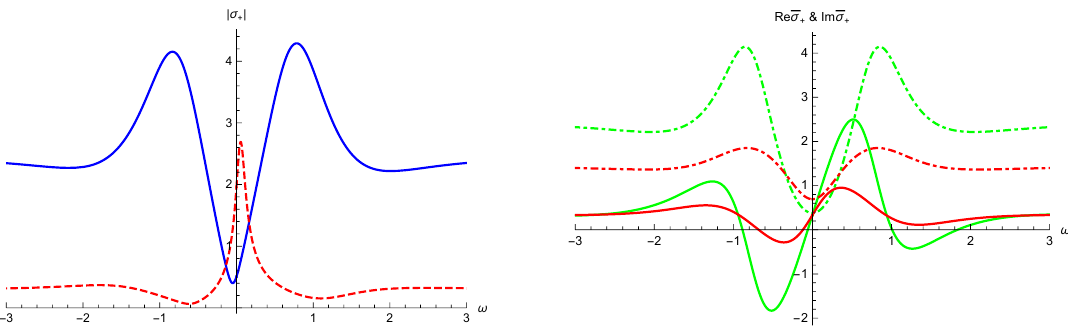
p p Figure 7 . Left plot: the AC conductivities j (cid:27) + j in terms of ! , with (cid:22) Q e = 0 : 9 ; (cid:22) Q m = 0 : 1 p p (red-dashed curve), (cid:22) Q e = 0 : 1 ; (cid:22) Q m = 0 : 9 (Blue-solid curve). Right plot: the AC conductivities Re(cid:22) (cid:27) + (Solid curves) and Im(cid:22) (cid:27) + (Dotted-dashed curves) in terms of ! , for (cid:12)xed k 1 = 0 : 1, k 2 = 0 : 4 p p (Green) and k 2 = 1 (Red), with (cid:22) Q m = 0 : 9 and (cid:22) Q e = 0 : 1. of (cid:12)gure 7 shows that as the anisotropy increases (or k increases) the amplitude of the 2 cyclotron frequency pole becomes smaller. This implies that, if the system has a su(cid:14)ciently large anisotropy, the cyclotron frequency pole cannot